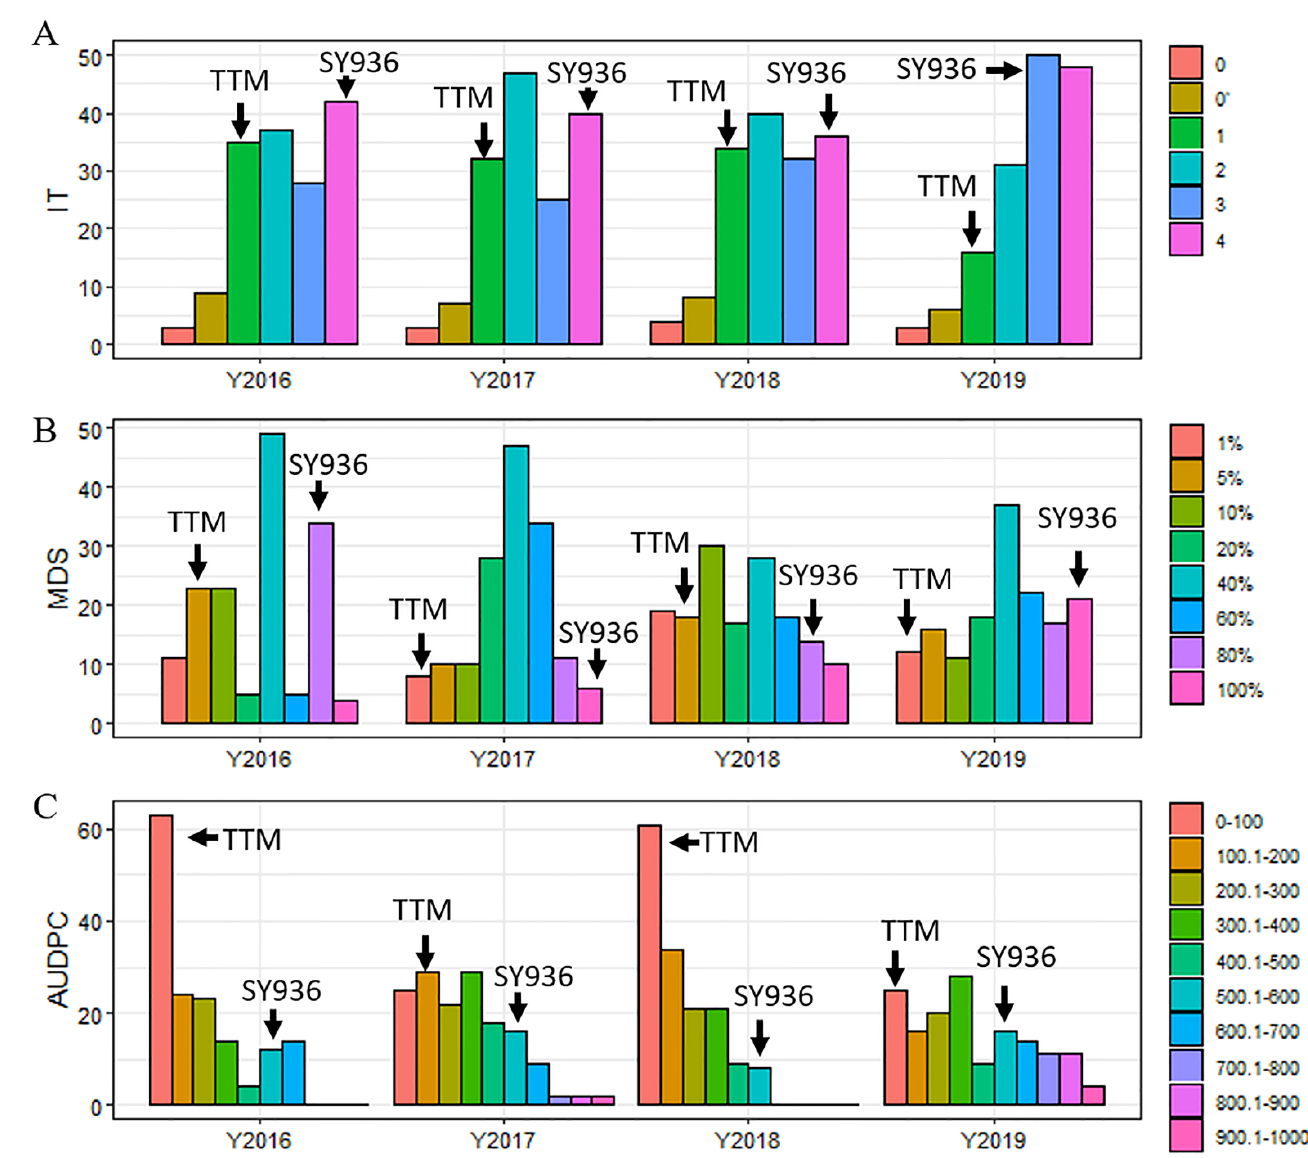
Figure 2. Distribution of infection types ( A ), maximum disease severity ( B ), and area under the disease progress curve ( C ) for the RIL population evaluated in four field experiments from 2016–2019. TTM and SY936 refer to the stripe-rust-tolerant parent Tutoumai and susceptible parent Siyang 936, respectively.